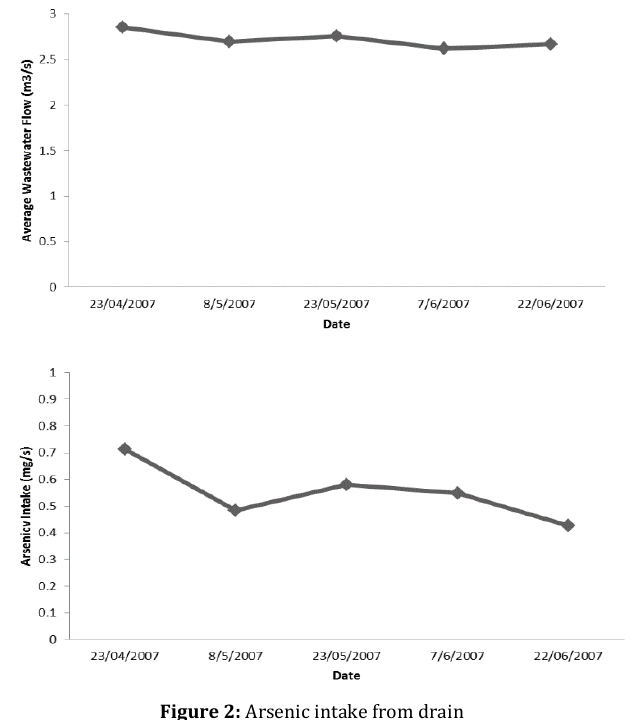
Figure 2: Arsenic intake from drain